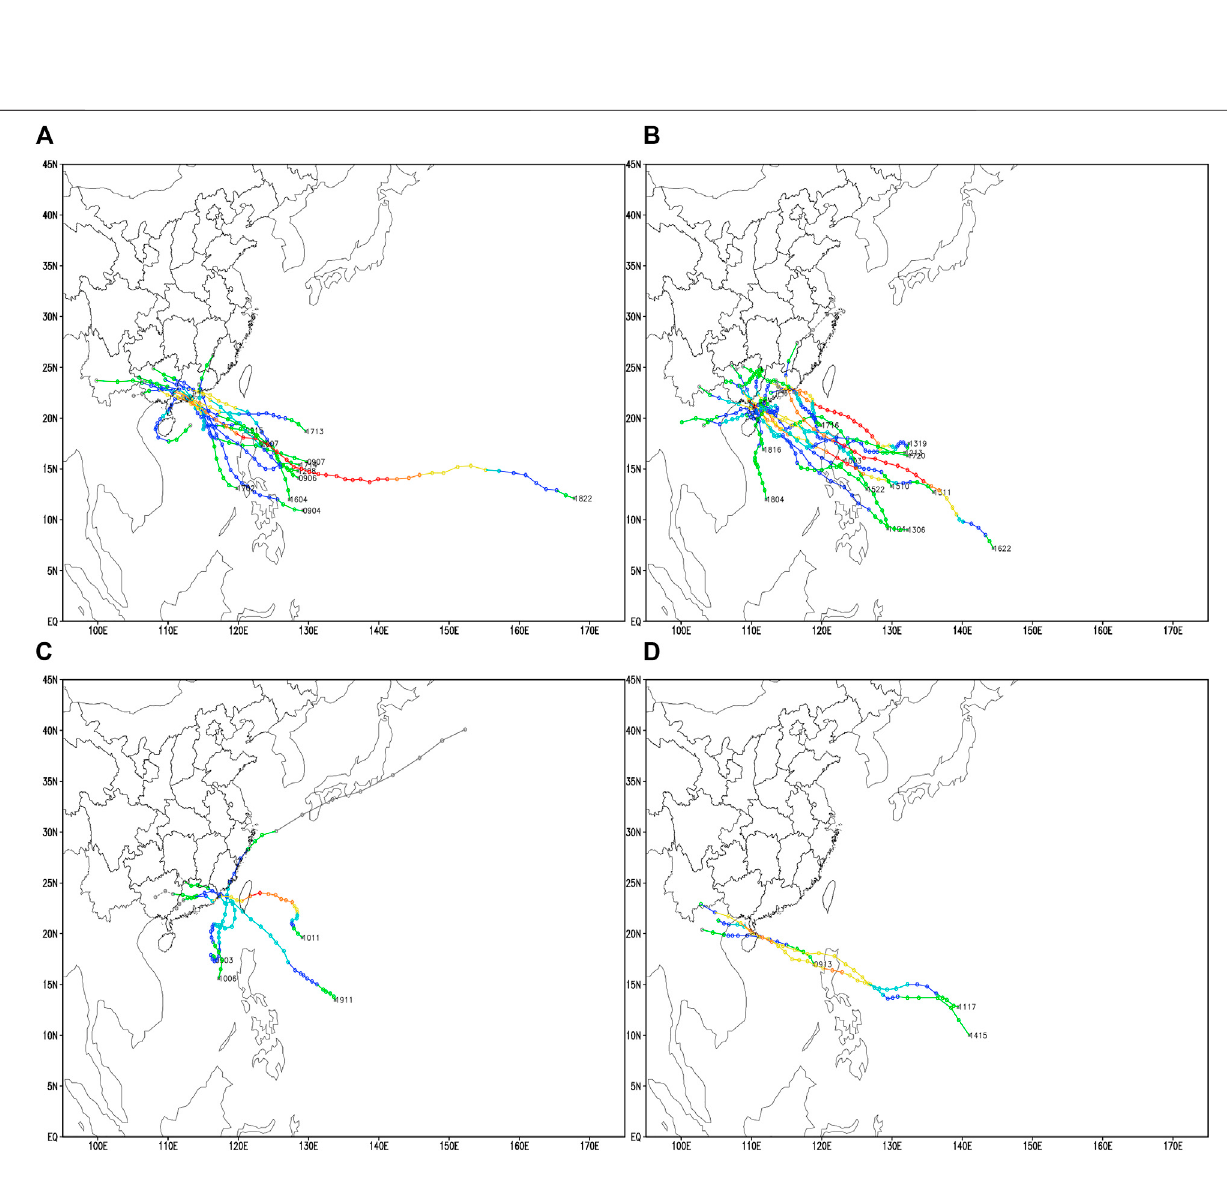
Frontiers in Earth Science |